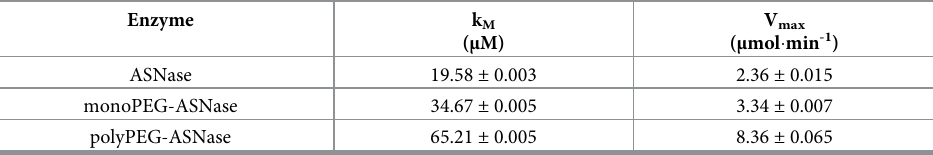
a All experiments were done in triplicate and error bars represent the standard deviation. The kinetic